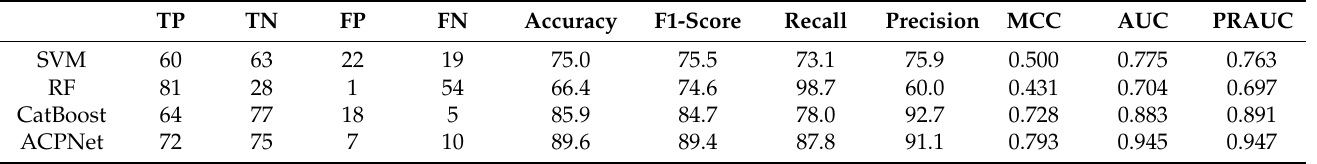
Table 4. Comparing results with traditional machine learning.